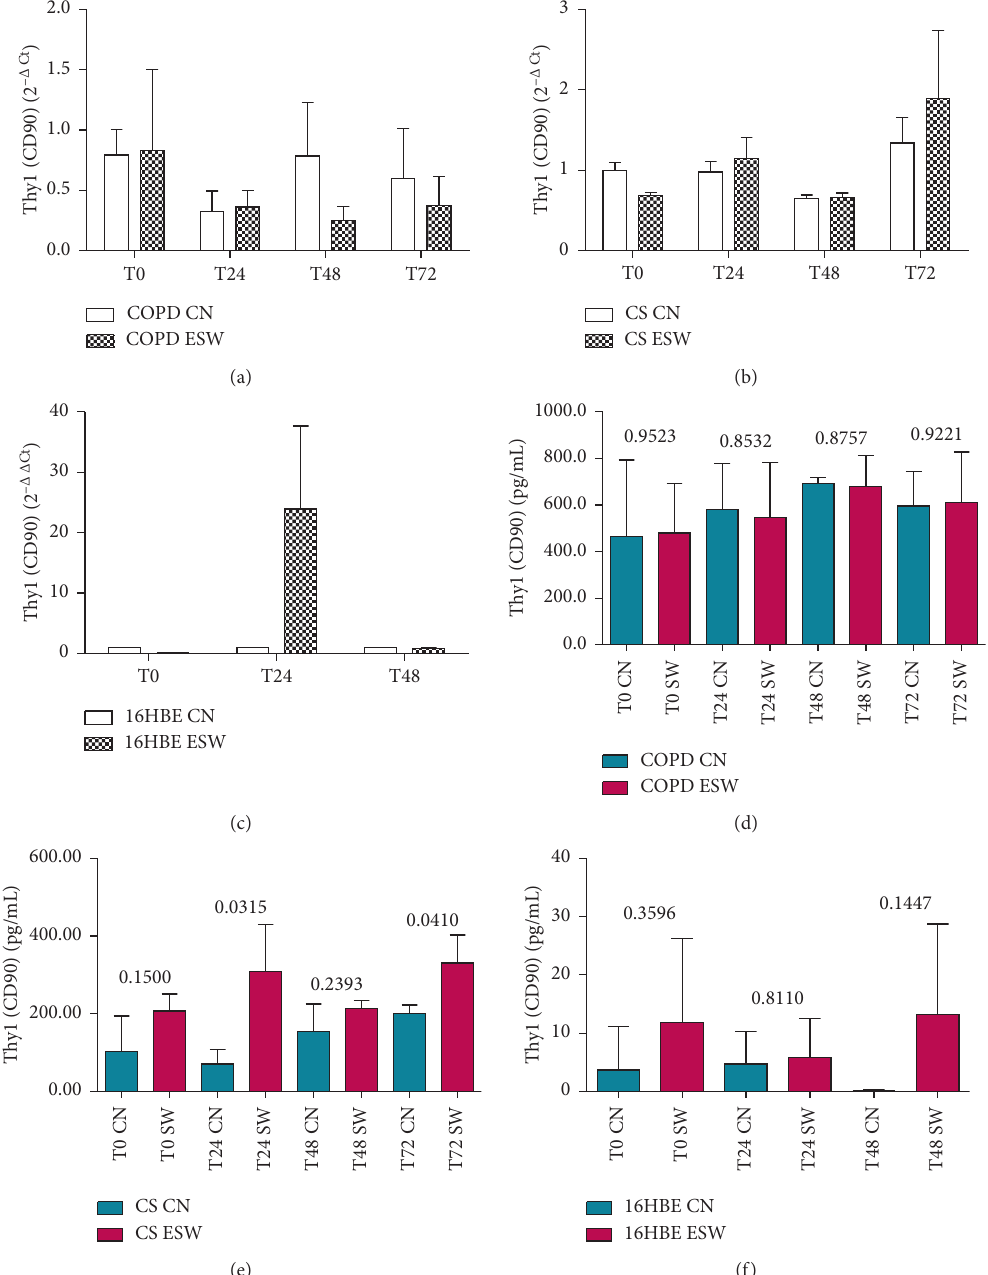
Figure 4: Thy1 (CD90) mRNA (a, b, c) and protein (d, e, f) expression after ESW treatment in primary bronchial fibroblasts of COPD patients (a, d), primary bronchial fibroblasts of control smokers (b, e), and bronchial epithelial cells (c, f). In primary bronchial fibroblasts of control smokers, Thy1 increased at protein level at 24 and 72h (e). T -test was used for comparative purposes, and p values are reported in the